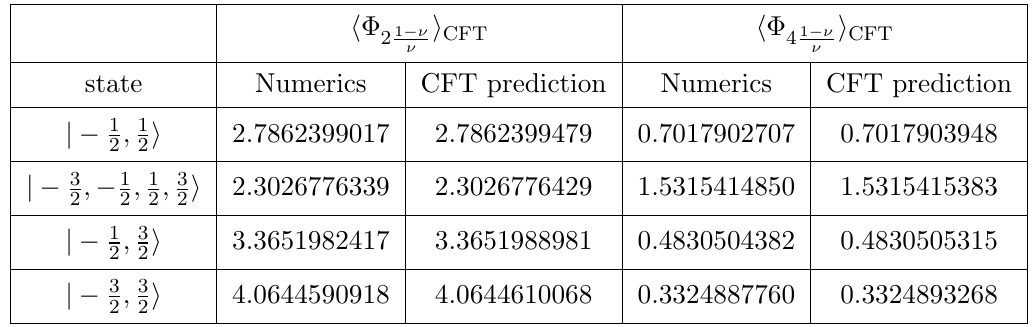
(0), with m = 1 ; 2, at 2 m (1 (cid:0) (cid:23) ) (cid:23)